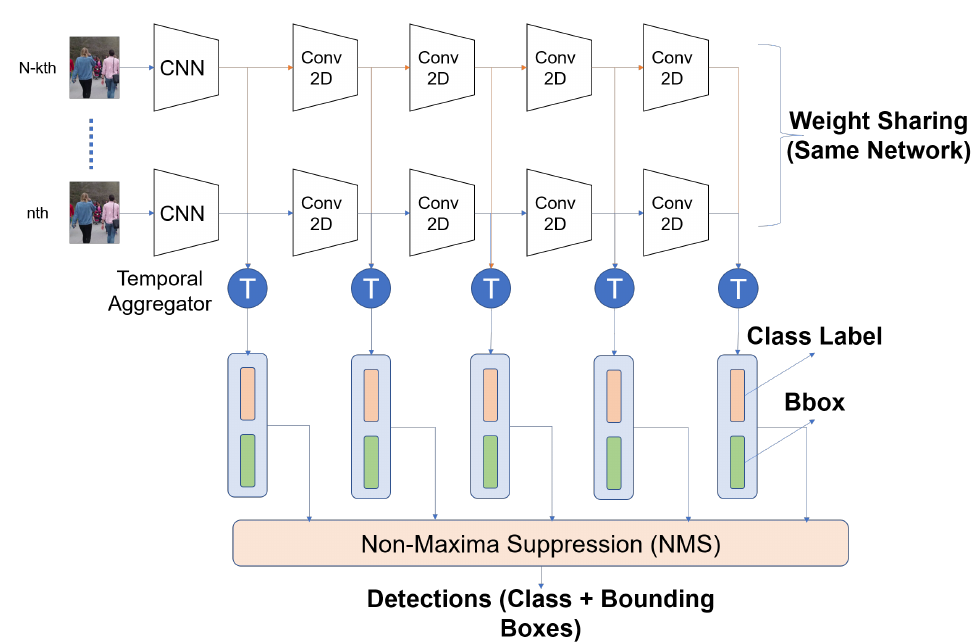
Figure 5. ACT Architecture [33] for action detection. It is similar to SSD, but it takes in multiple frames as input and applies aggregates the features for every time step before doing classification and regression. The network applied to each frame is the